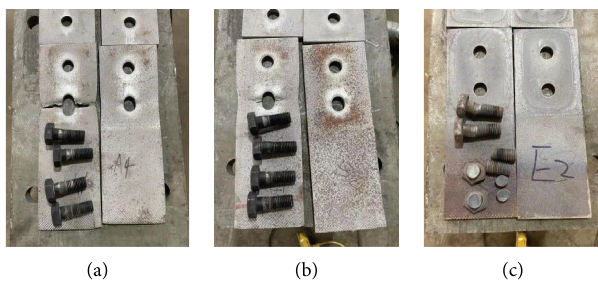
Figure 3: Failure of ordinary high-strength bolt specimens. (a) A4. (b) B4. (c) E2.